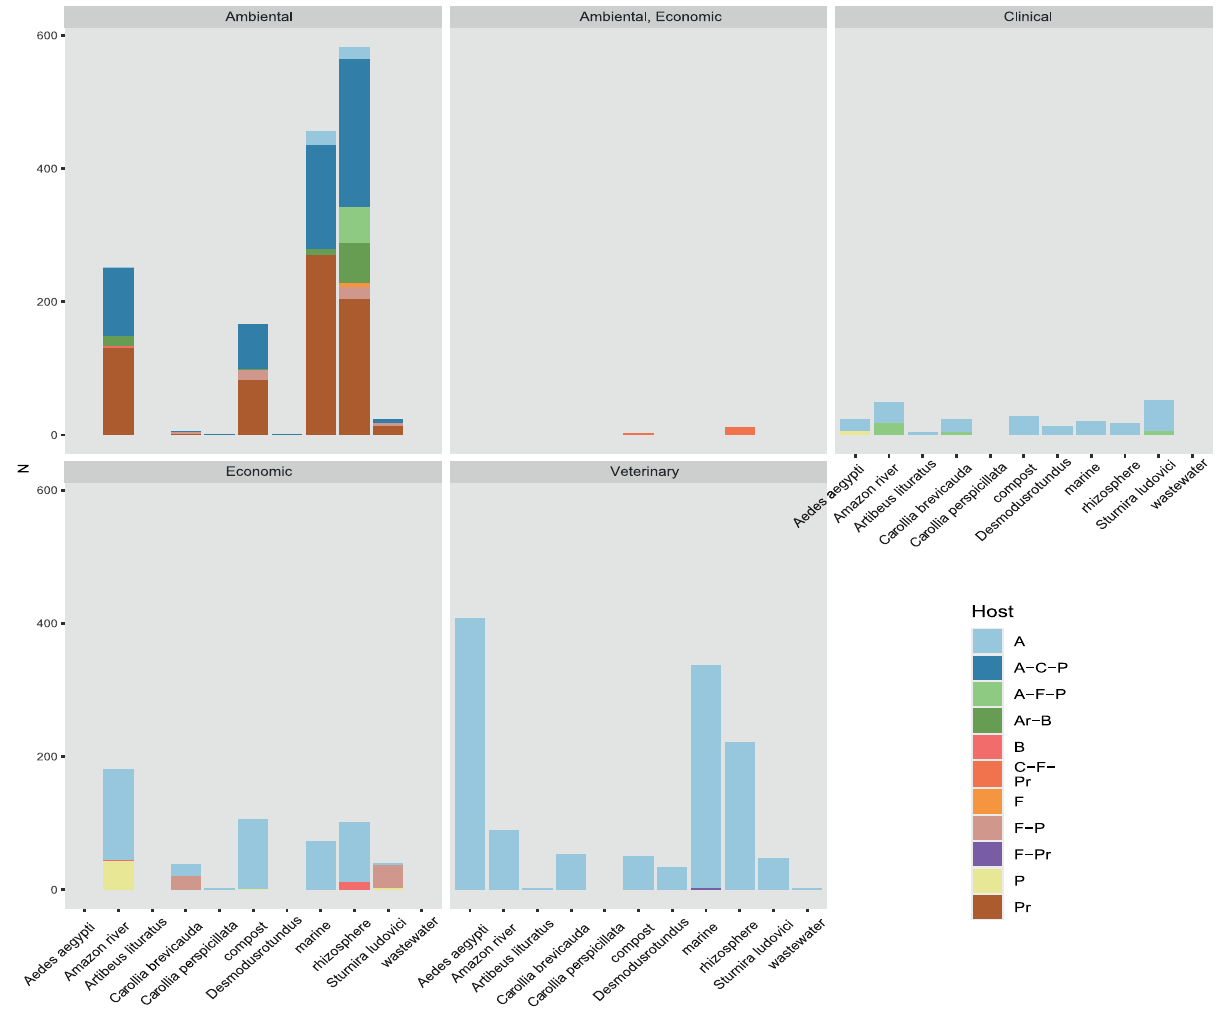
FIGURE9| Rate of sequences classi fi ed by their relevance clinical, environmental, economic, or veterinary relevance of the taxonomic group to which they belong. Also shown is the host range of the virome of each sample. Their hosts are coded here as A (Animalia), Ar (Archaea), B (Bacteria), C (Chromista), F (Fungi), and P